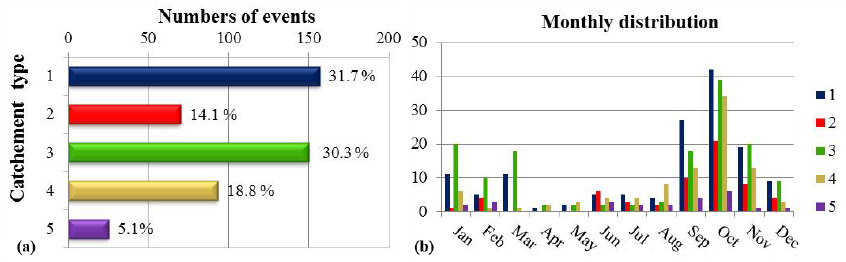
Figure 10. Number (a) and monthly distribution (b) of flash floods events for the different classes of catchments. Catchment class key: (1) carbonate catchment with pyroclastic cover; (2) carbonate catchment without pyroclastic cover; (3) carbonate catchment with pyroclastic cover and outlet to the sea; (4) volcanic catchment; (5) volcanic catchment with outlet to the sea.